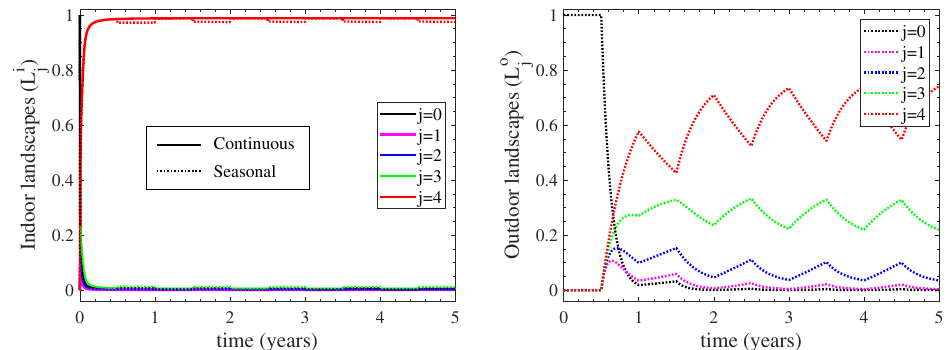
Figure 5. Environmental contamination to the infection spread provided by the landscapes L i of the indoor ( left ) and outdoor ( right ) compartments, respectively. The contamination landscape in the continuous housing case is depicted with solid curves, while that of the seasonal housing is depicted with dotted curves; in the latter case the herd remains indoors/outdoors during the first/second half of each year. The outdoor environment is only activated in the seasonal housing